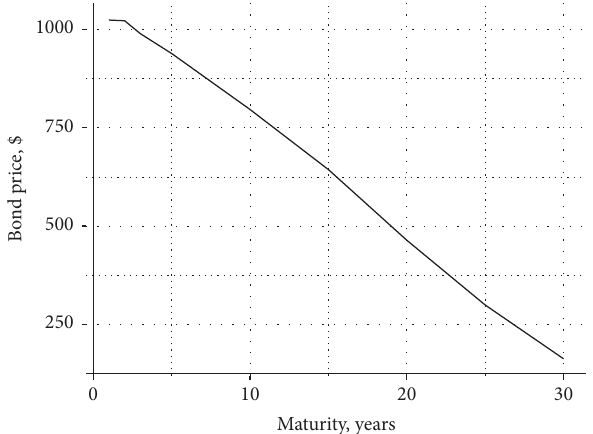
Figure 4: Cyber bond price vs. maturity.